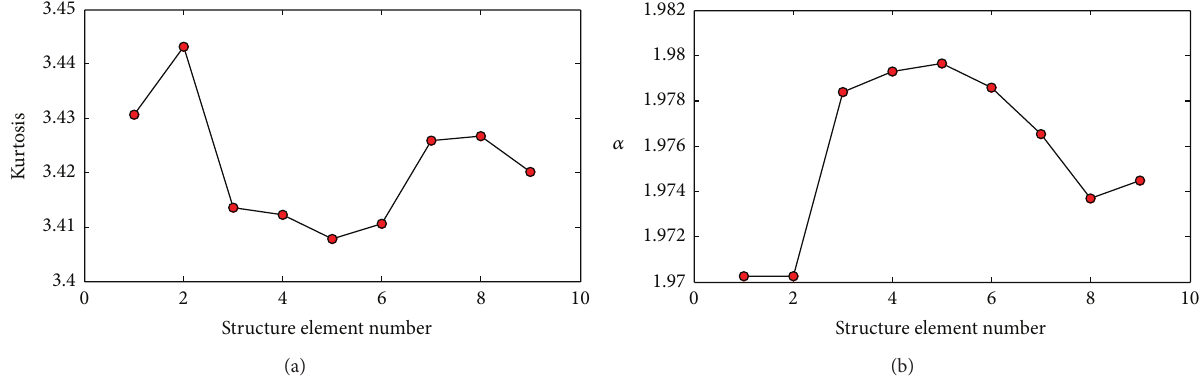
Figure 17: (a) Kurtosis value versus length of SE for 240,000 samples; (b) 𝛼 value versus length of SE for 240,000 samples.